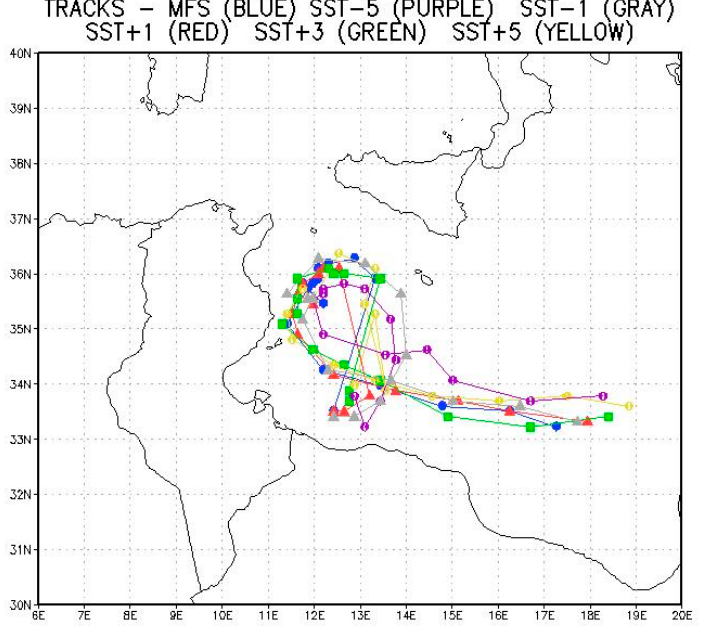
Figure 18. Storm tracks for the period 13 December 2005 00 UTC—15 December 2005 00UTC for the MFS run (blue). For selected SST anomaly runs: SST-5 (purple), SST-1 (gray), SST+1 (red), SST+3 (green) and SST+5 (yellow).